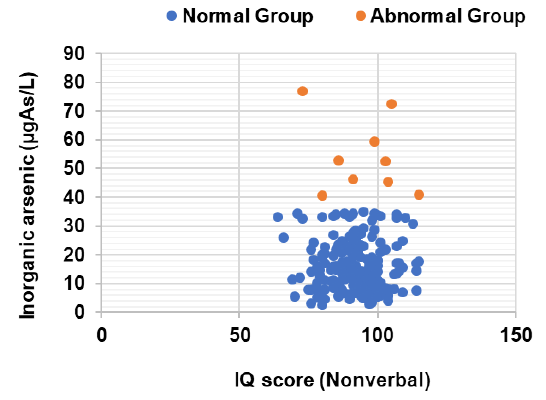
Figure 1: Level of inorganic arsenic in the urine of children (n=199). Assay was done by inductively coupled plasma mass spectrometry.